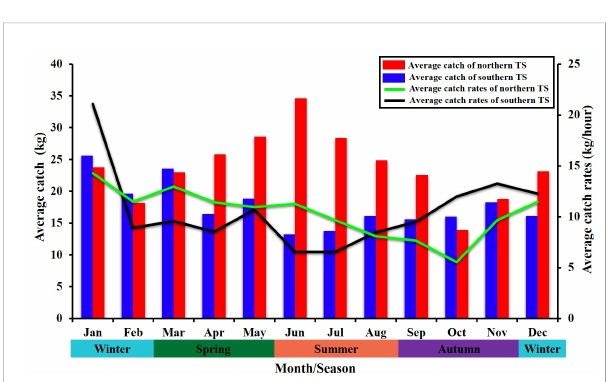
FIGURE 3 Monthly average catches and catch rates of greater amberjack in the southern and northern Taiwan Strait.